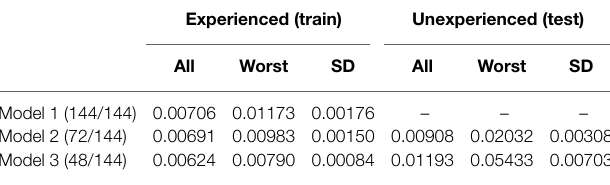
TABLE 3 | Performance of behavior generation